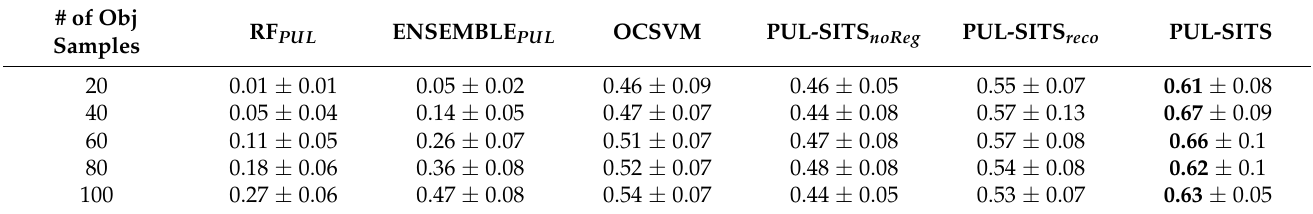
Table 13. Performances in terms of the Kappa measure of the different competing strategies when the land cover class of interest (the positive class) is Forest